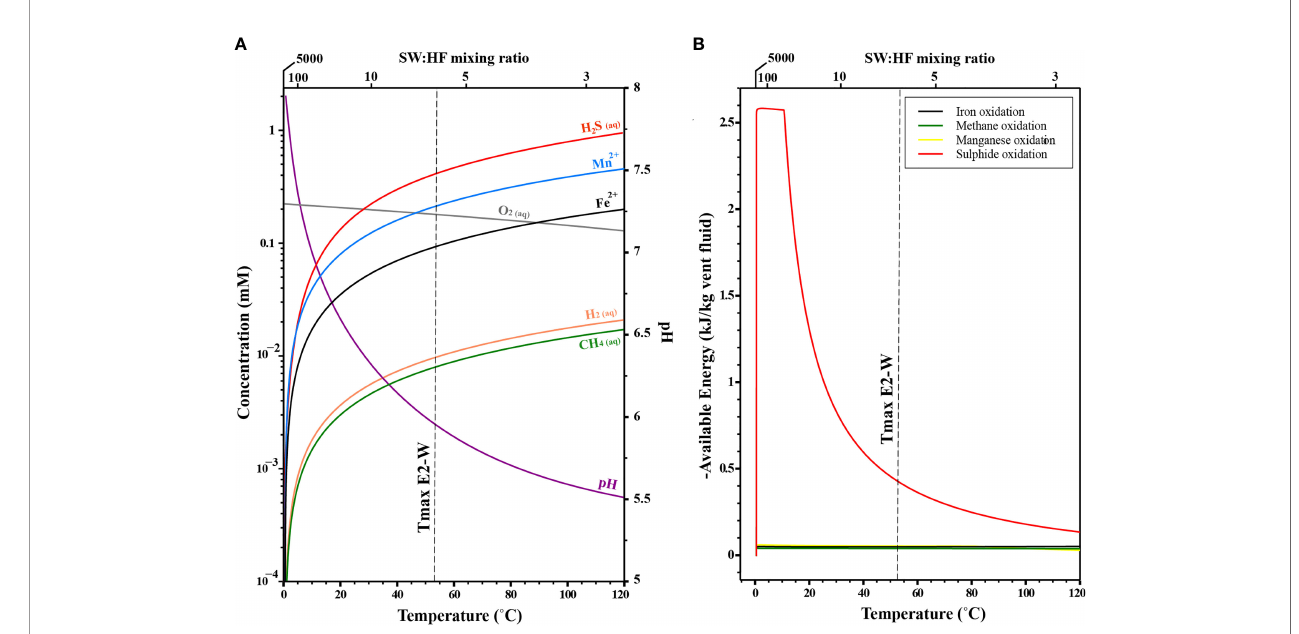
FIGURE 10 | Thermodynamic models for chemical gradient and associated energy landscape at E2. (A) Modelled concentration of various species as a function of temperature and mixing ratios. (B) Modelled energy available for the various reactions as a function of temperature and mixing